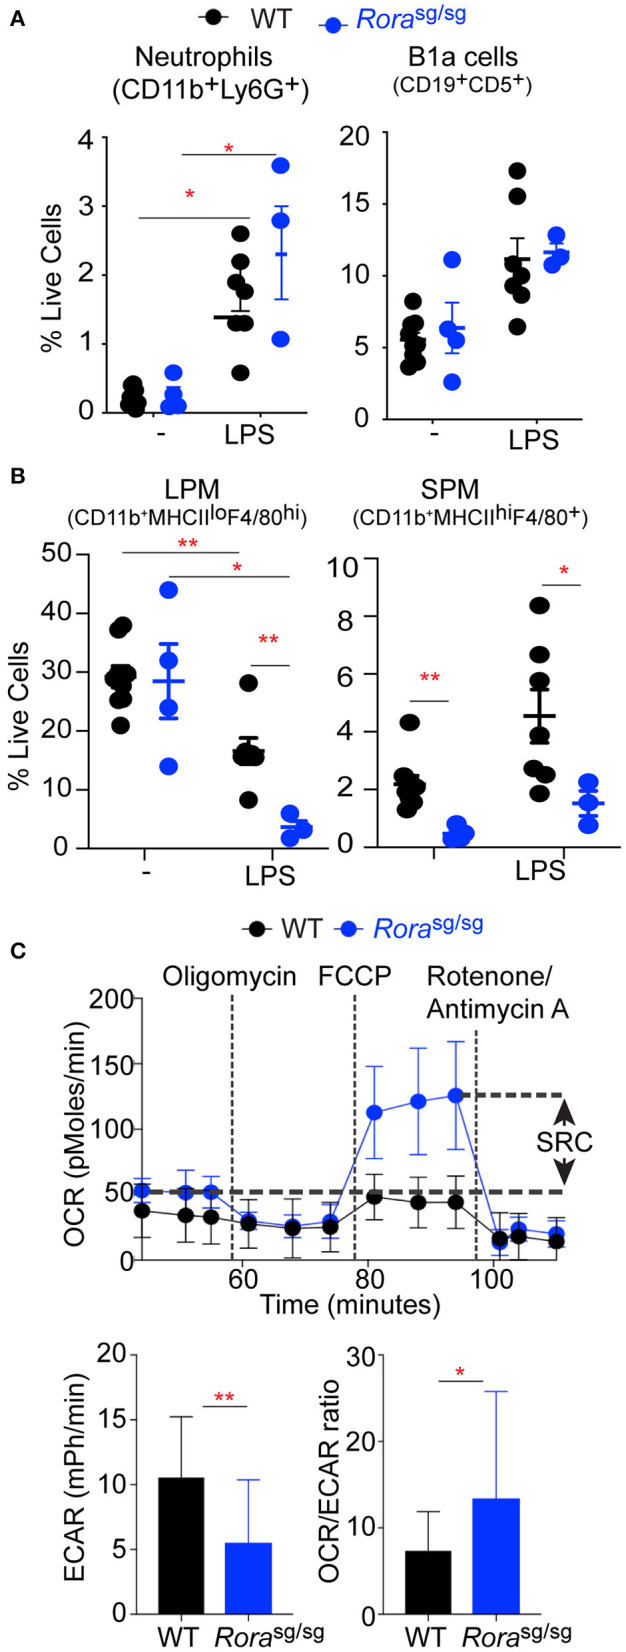
Rorasg/sg mice have an altered macrophage response in a naïve state and in response to LPS. Flow cytometric analysis of (A) neutrophils (CD11b+Ly6G+), B-1cells (CD19+CD5+) and (B) large peritoneal macrophages (LPM; CD11b+F4/80hiMHCIIlo) and small peritoneal macrophages (SPM; CD11b+F4/80+MHCIIhi) isolated from peritoneum of 3–9 naïve WT or Rorasg/sg mice and WT and Rorasg/sg mice 3 h post injection of 0.2 mg/kg UP-LPS. (C) Extracellular flux analysis of naïve peritoneal macrophages from WT (n = 3 mice, 8 replicates per mouse) and Rorasg/sg (n = 3 mice, 6 replicates per mouse) mice showing SRC, basal ECAR and OCR:ECAR ratio. *P < 0.05, **P < 0.01.